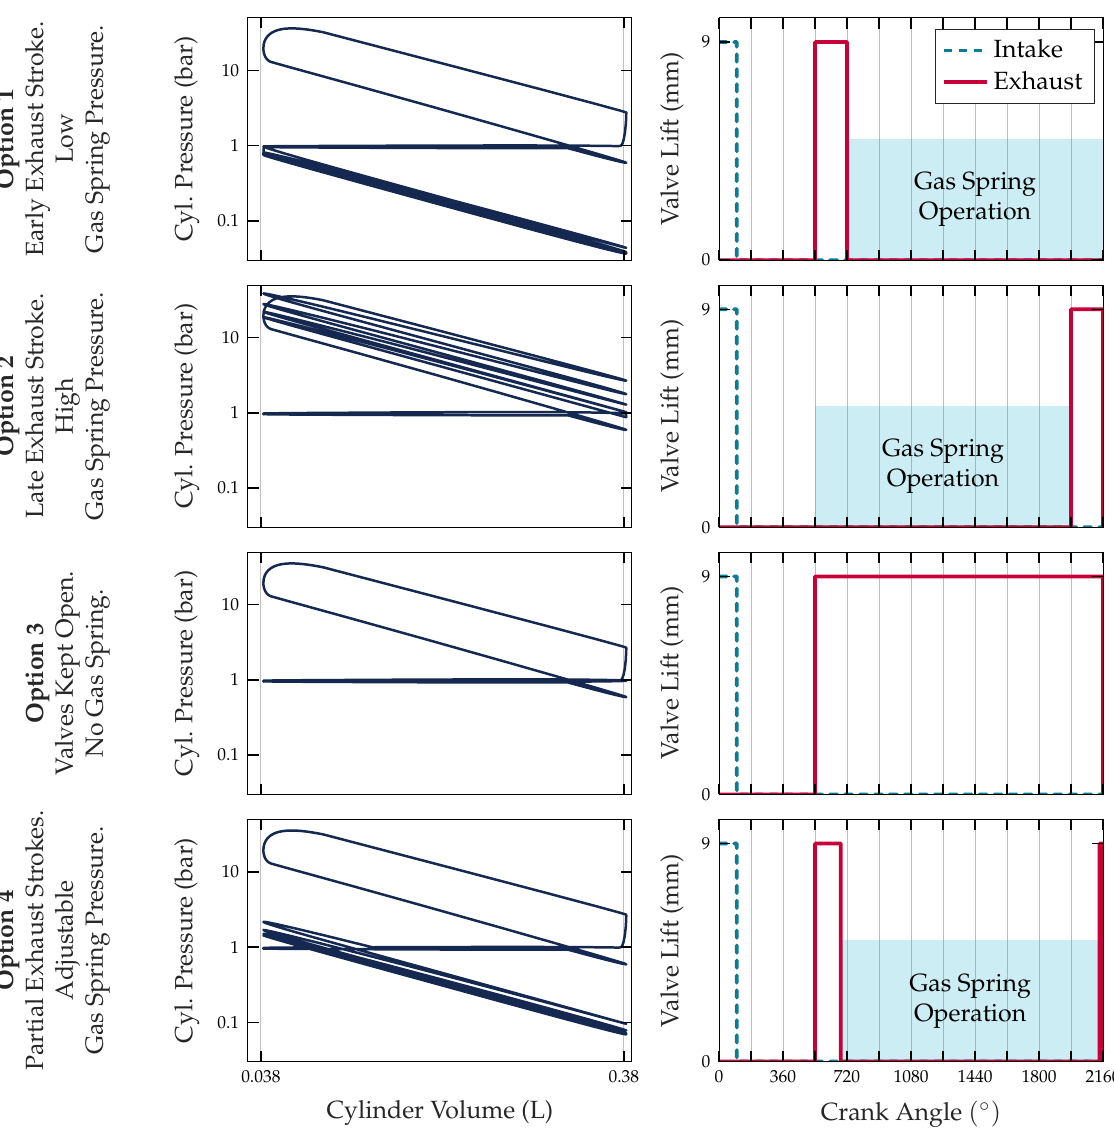
Figure 2. Simulations of four different options to transit into and out of the gas spring operation. Valve timings and corresponding pV-diagrams are shown for an idealized 12-stroke